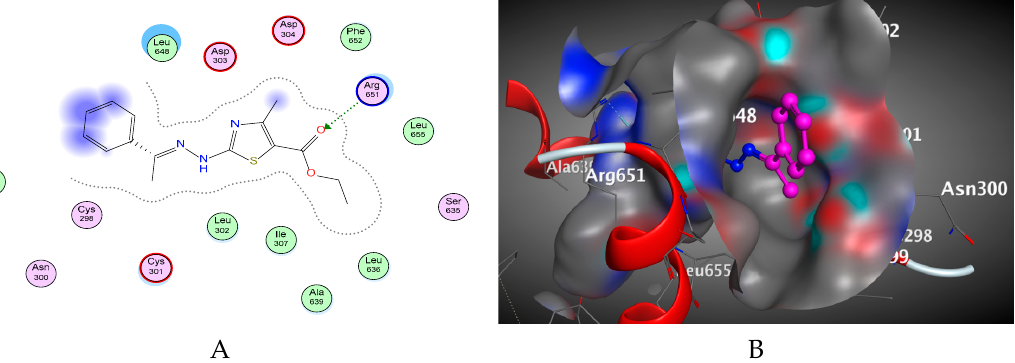
Figure 2. ( A ) 2D pose and ( B ) surface map of the interaction of 1 into the active sites of SARS-CoV-2 RdRp (PDB: 7bv2).